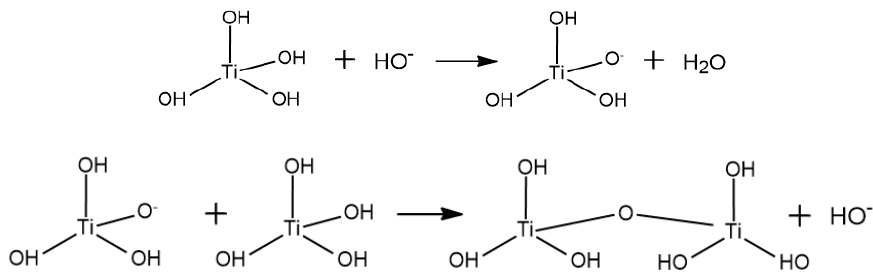
Figure A4. Two step homo-condensation: between Ti(OH) 4 molecules.